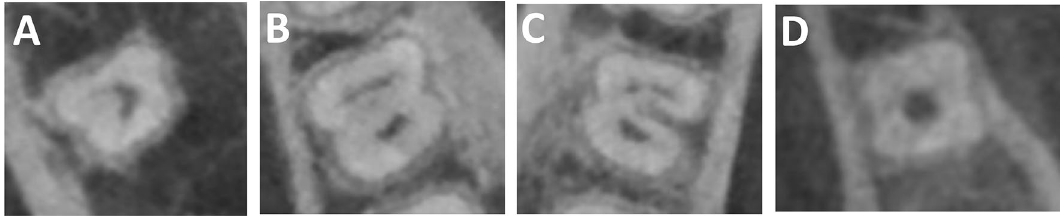
Figure 2. Example of oblique slicing module perpendicular to the long axis of a mandibular second molar. ( A ) Type 1—Continuous C with no separation or division, ( B ) Type 2—kidney-shaped semi-column, ( C ) Type 3—